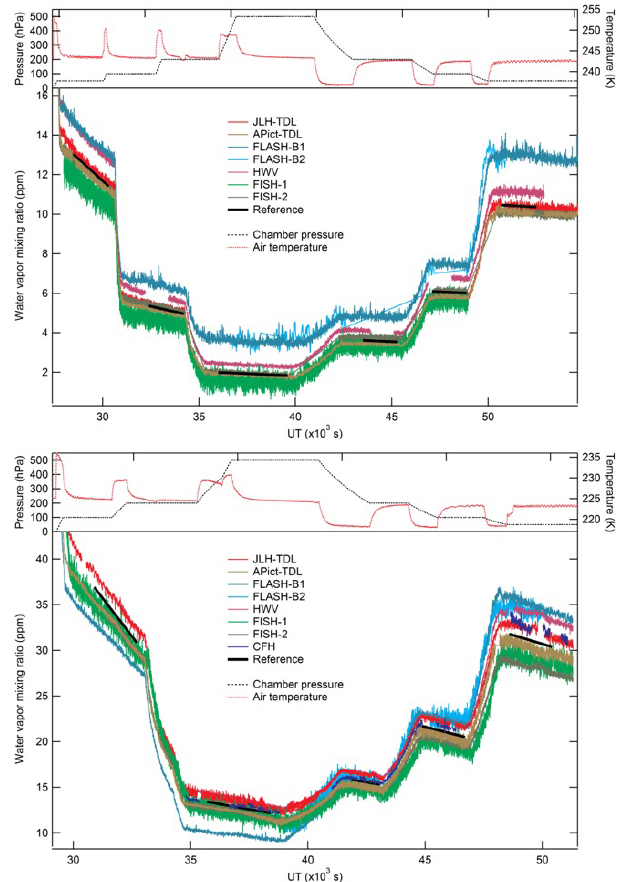
Figure 5. Example time series of AIDA water vapor mixing ra- tios (1s averages) as reported by the core instruments during the static experiments on 15 October (top) and 16 October (bottom). Data from the FLASH instruments are not included in the reference value (see text). The chamber pressures and temperatures are given in the top panel of each graph. The black lines are the reference functions for each segment and indicate the time intervals used in the intercomparison. The average of each reference function yields the reference value for each segment, all of which are given in Ta- ble